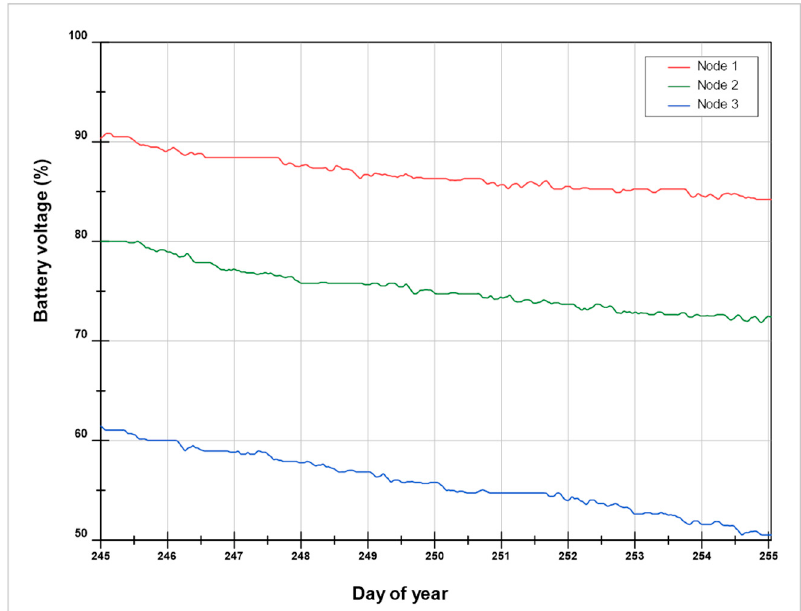
Figure 13. Trial 5: voltage evolution of the three nodes distributed in several places inside of the refrigerated truck container.